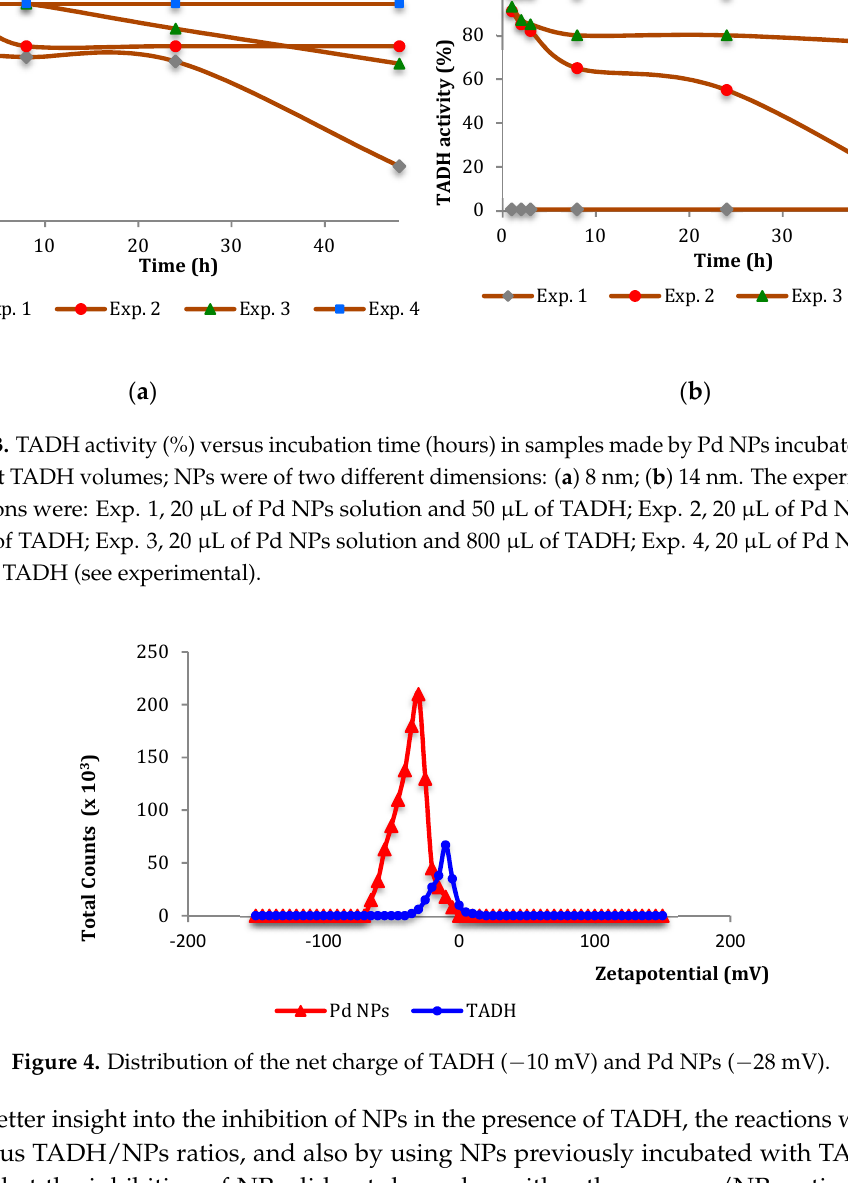
Figure 3. TADH activity (%) versus incubation time (hours) in samples made by Pd NPs incubated with different TADH volumes; NPs were of two different dimensions: ( a ) 8 nm; ( b ) 14 nm. The experimental conditions were: Exp. 1, 20 μ L of Pd NPs solution and 50 μ L of TADH; Exp. 2, 20 μ L of Pd NPs and 100 μ L of TADH; Exp. 3, 20 μ L of Pd NPs solution and 800 μ L of TADH; Exp. 4, 20 μ L of Pd NPs and 3 mL of TADH (see experimental).